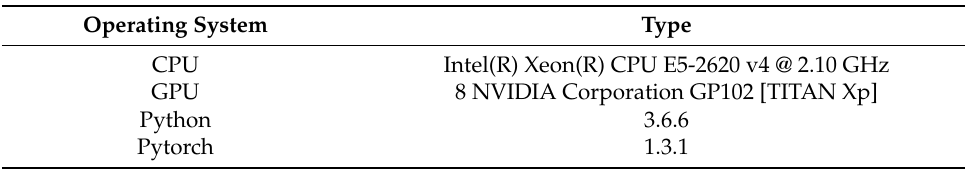
Table 2. Experimental environment configuration.